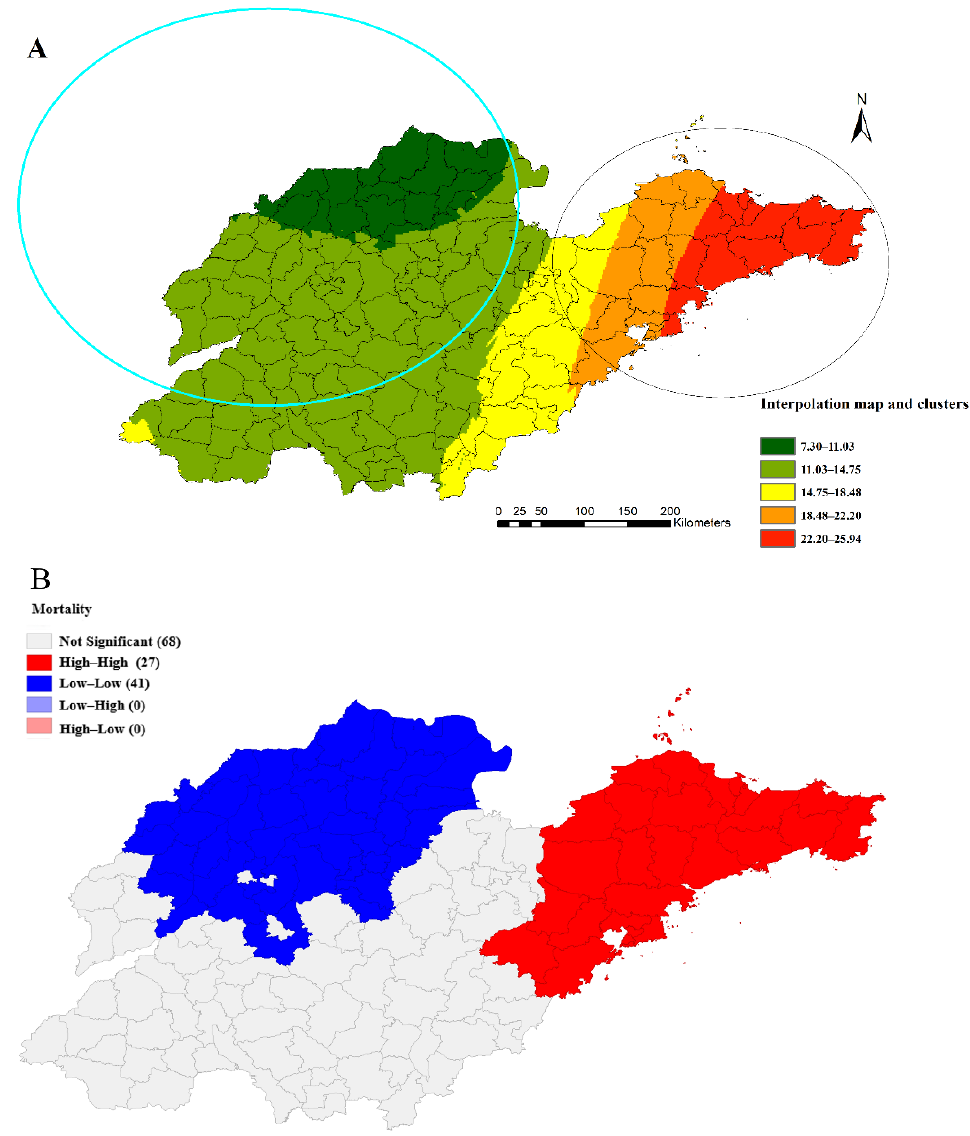
Figure 3. Kriging interpolation map of diabetes mortality ( A ) and Local Indicators of Spatial Asso- ciation map ( B ) of all counties or districts in Shandong Province, China, 2014.